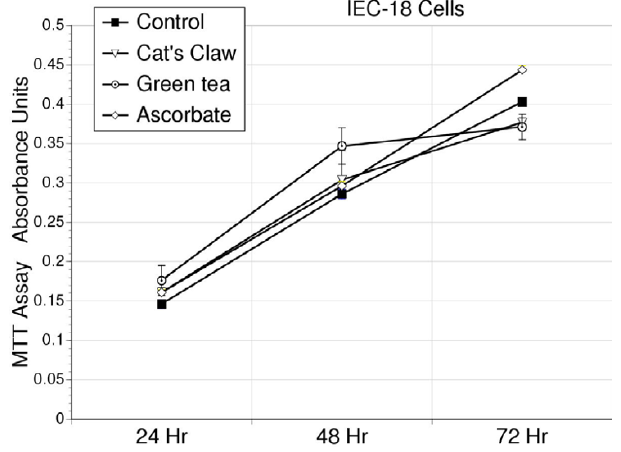
Figure 1 Proliferation curves for AGS cells, based on the MTT assay, for cell respiration over a 72 hour period in response to the antioxidants – cat's claw, green tea, or vitamin C. These anti- oxidants had no detrimental effect on cell proliferation at the concentrations used in this study, 10 µ g/ml.